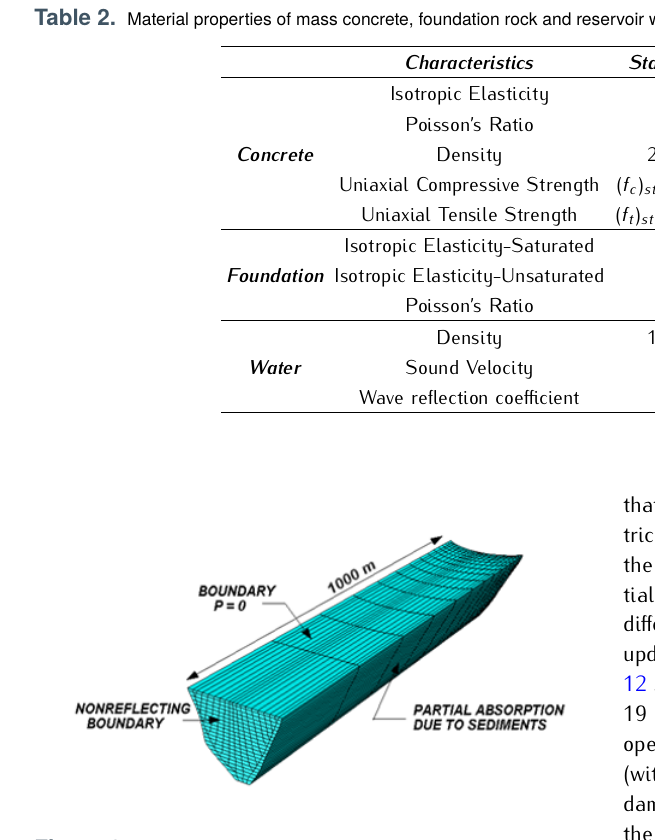
Figure 6. Finite element model of reservoir and boundaries